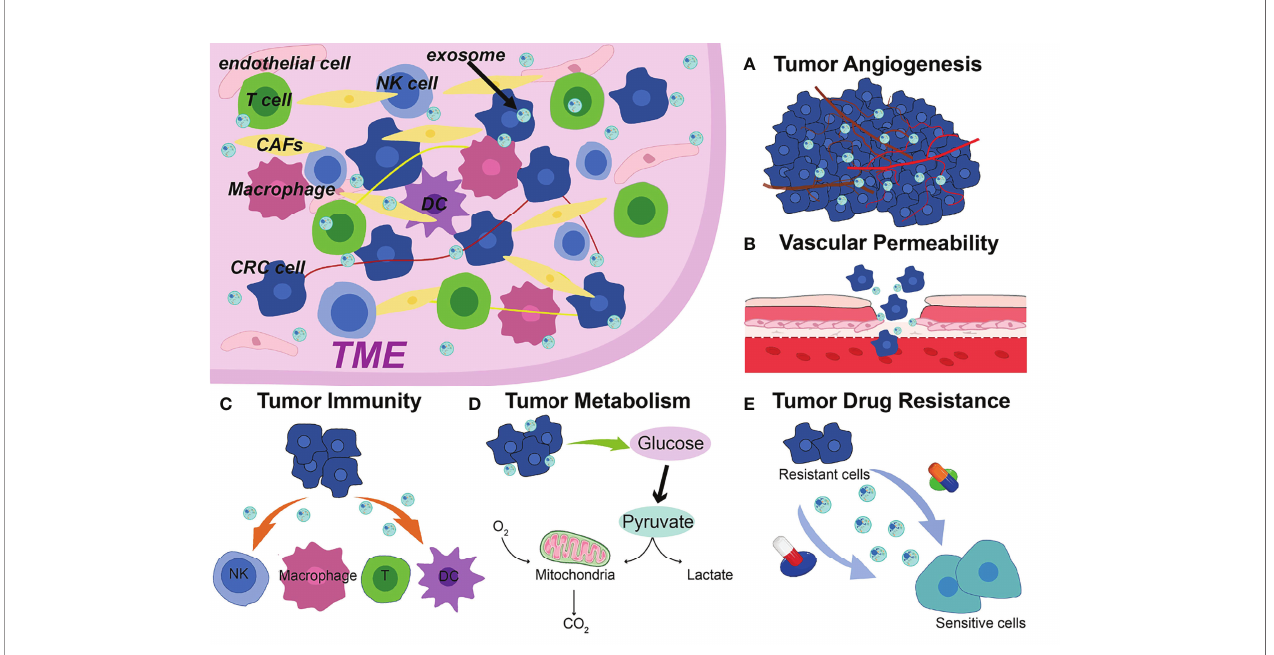
FIGURE 1 | Exosomal ncRNAs contribute to the (A) tumor angiogenesis, (B) vascular permeability, (C) tumor immunity, (D) tumor metabolism, (E) drug resistance in the TME of